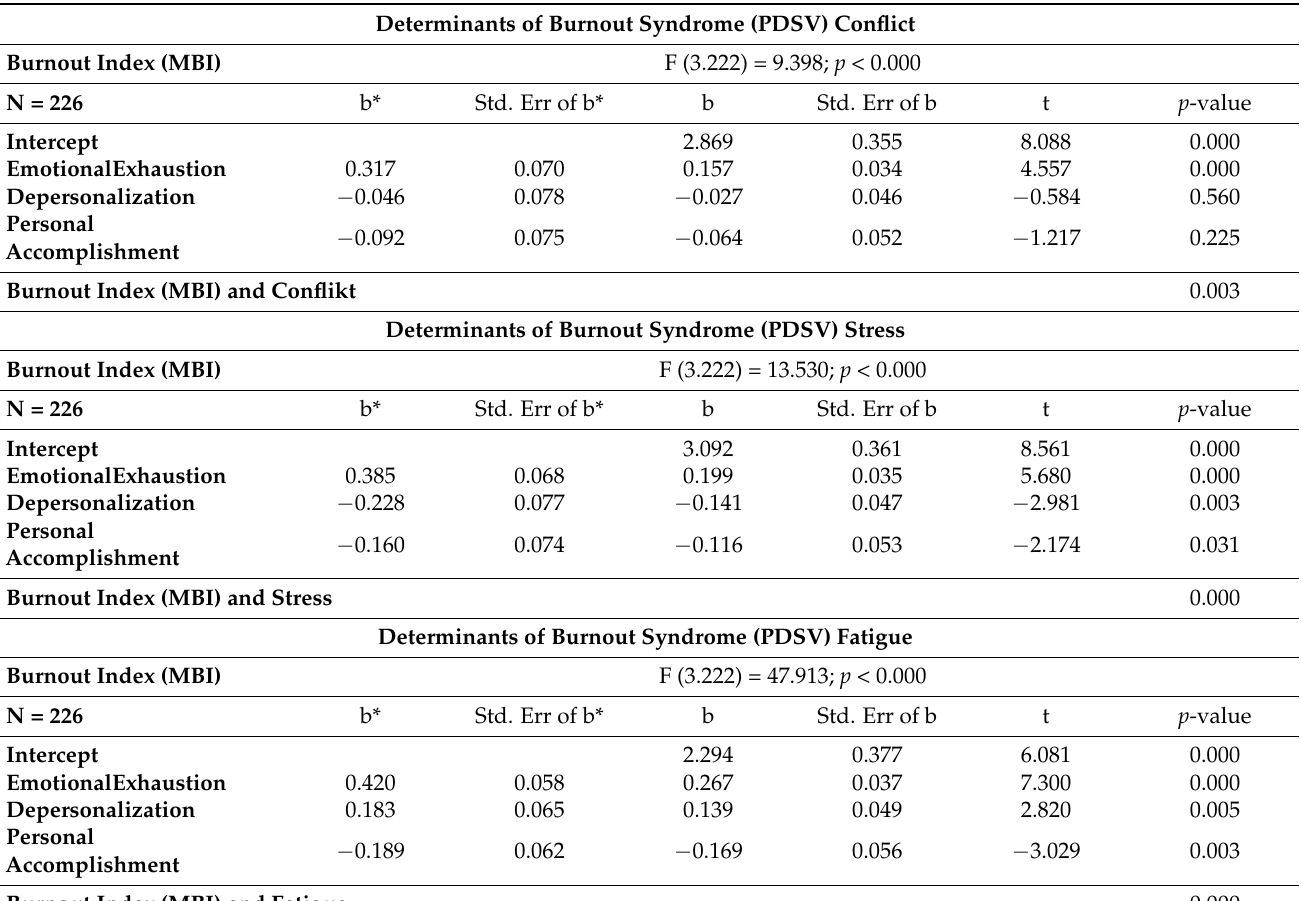
Table 6. Regression between the determinants of burnout (PDSV) and the burnout rate (MBI) of public administration